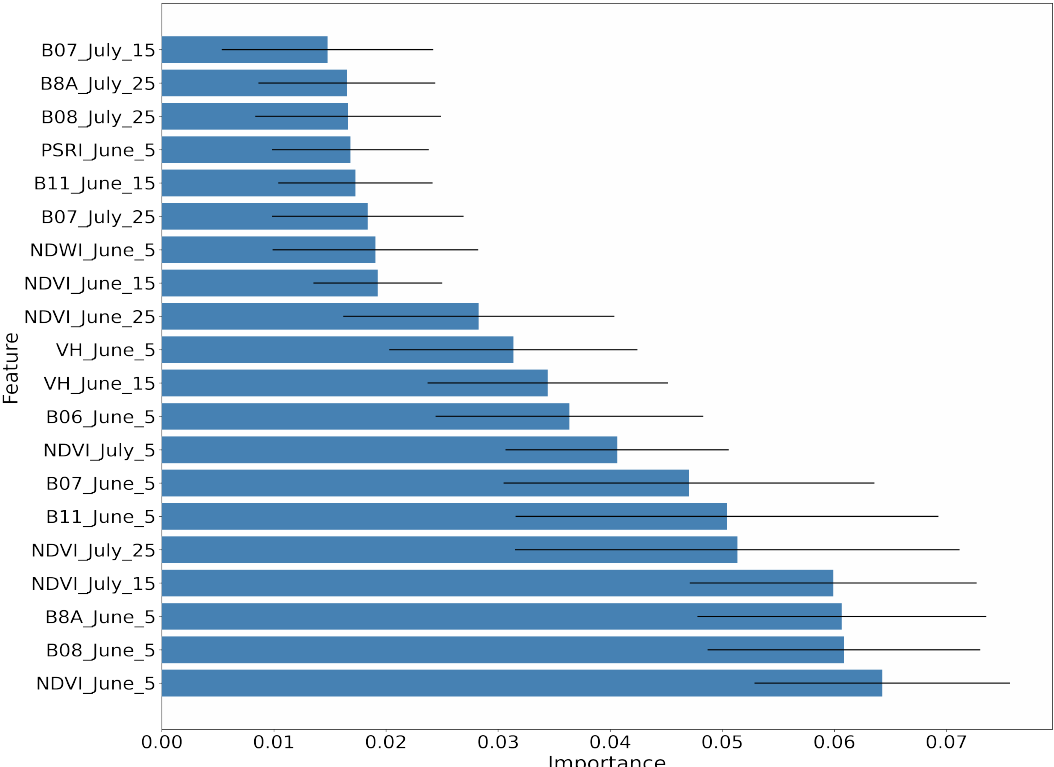
Figure 14. Average RF importance of the top ranked features, along with the respective standard deviation for 10 differ- ent runs.